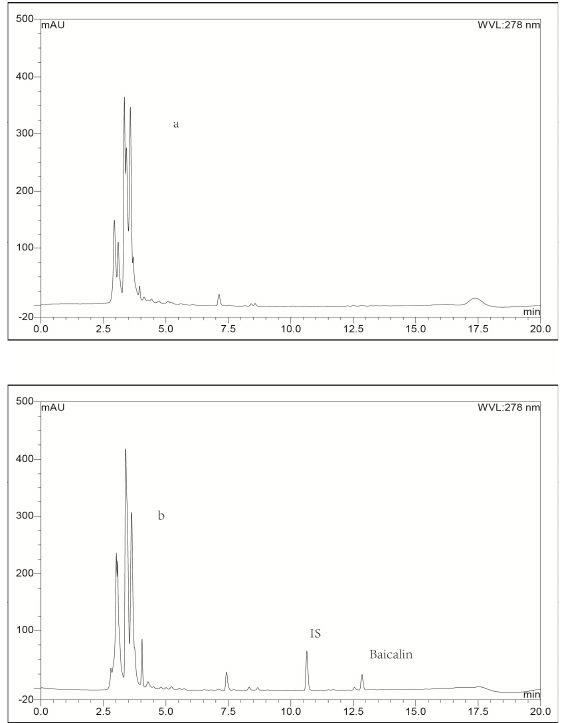
Figure 9. Representative LC-UV chromatograms obtained for blank brain tissue ( a ) and brain bio-sample collected from a rabbit at 0.25 h after intravenous administration of baicalin-loaded liposomes at a dose of 10 mg/kg + IS ( b ).